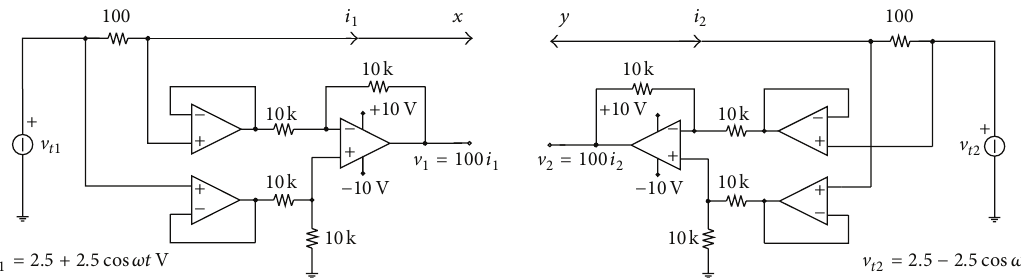
Figure 4: Auxiliary circuit used to apply voltages V 𝑡1 and V 𝑡2 to the circuits in Figures 3(a) and 3(b) and to measure the absorbed currents 𝑖 1 and 𝑖 2 .